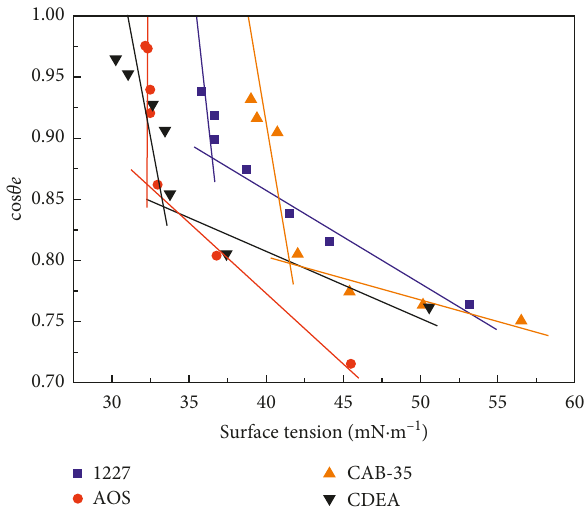
Figure 4: The relationship between c